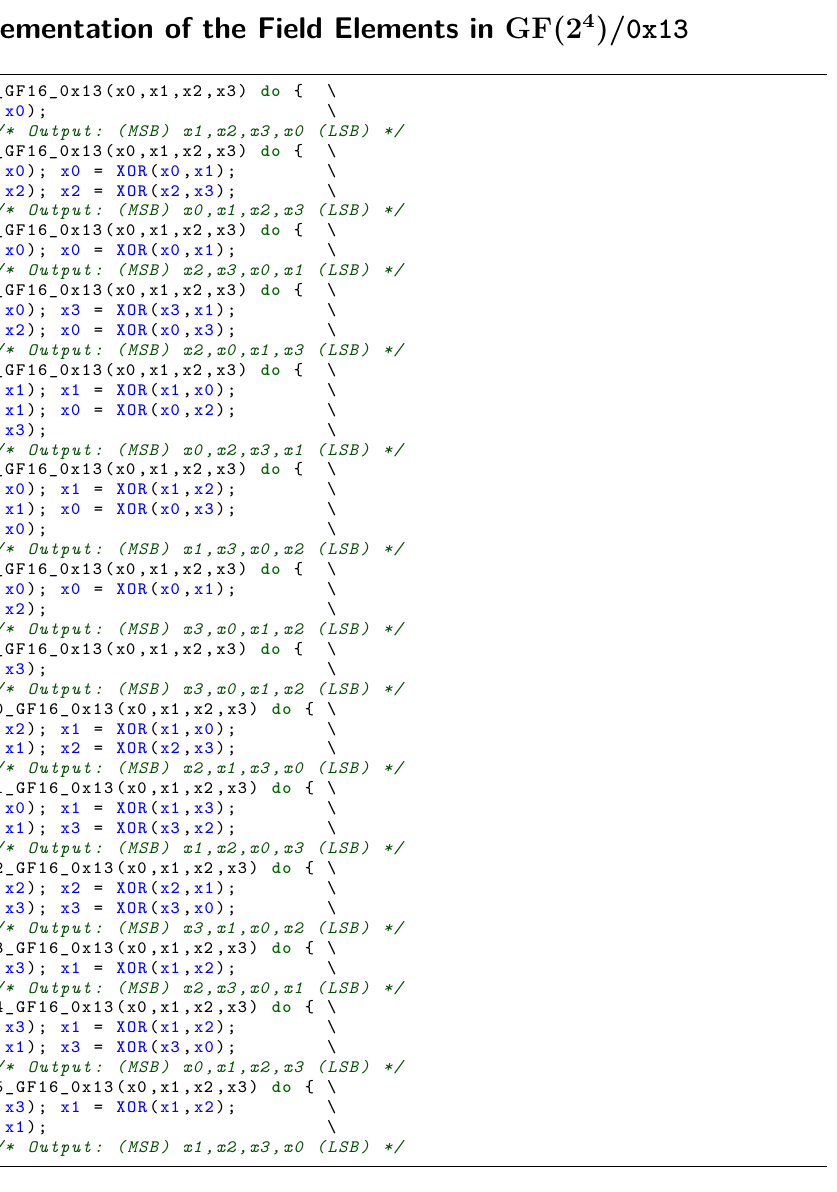
Figure 2: Minimal implementations of GF (16) / 0x13 field elements under the s-XOR metric. The inputs are given as x0,x1,x2,x3 , where x0 is the MSB and x3 the